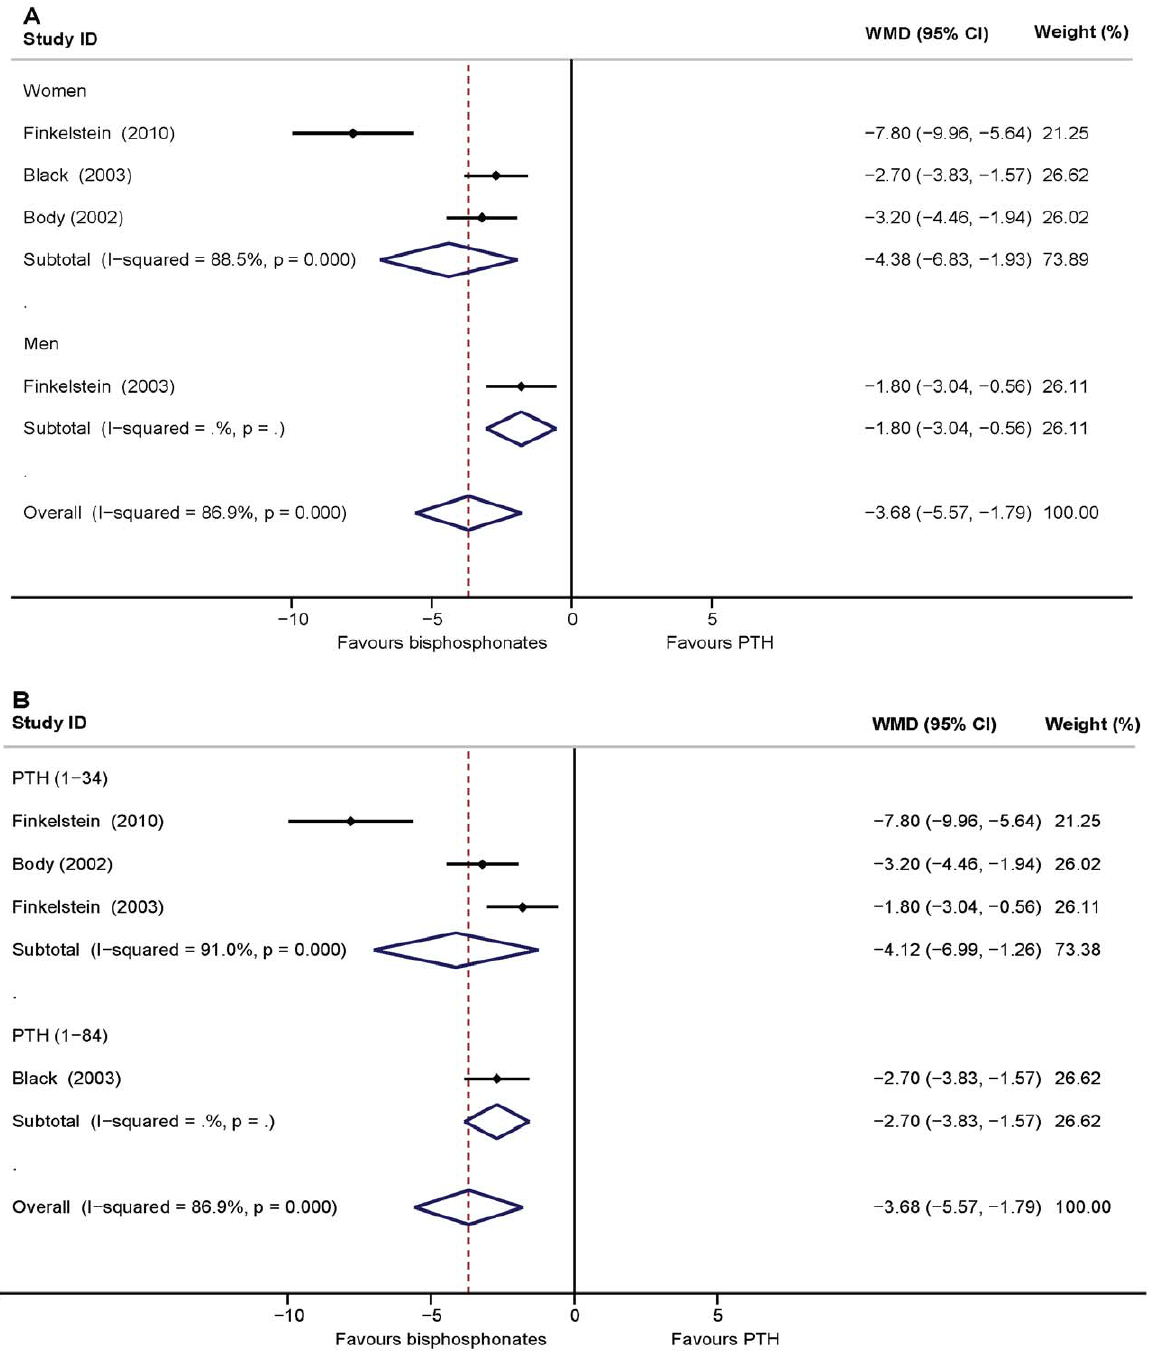
Figure 6. Assessment of the effects of PTH versus bisphosphonates on BMD of the distal radius. A: Subgrouped analysis of PTH versus bisphosphonates treatment on BMD of the distal radius in women and men. B: Subgrouped analysis of PTH (1–34) and PTH (1–84) versus bisphosphonates treatment on BMD of the distal radius.